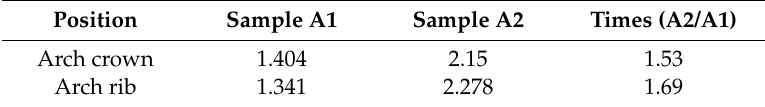
Table 4. The earth pressure coefficients of different samples.